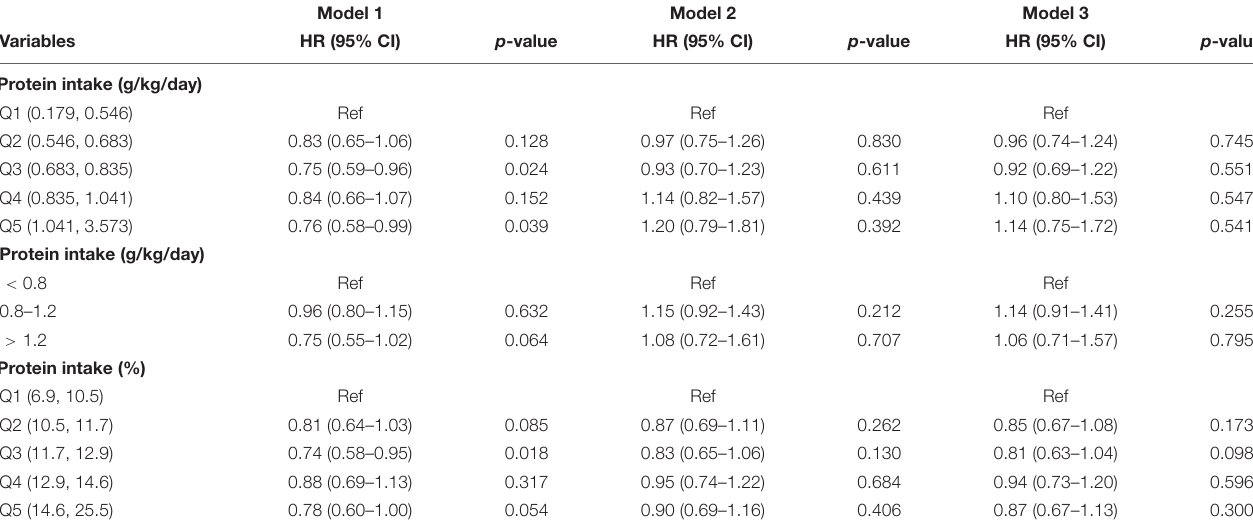
TABLE 3 | Multiple Cox proportional hazard regression analysis for all-cause mortality of protein intake